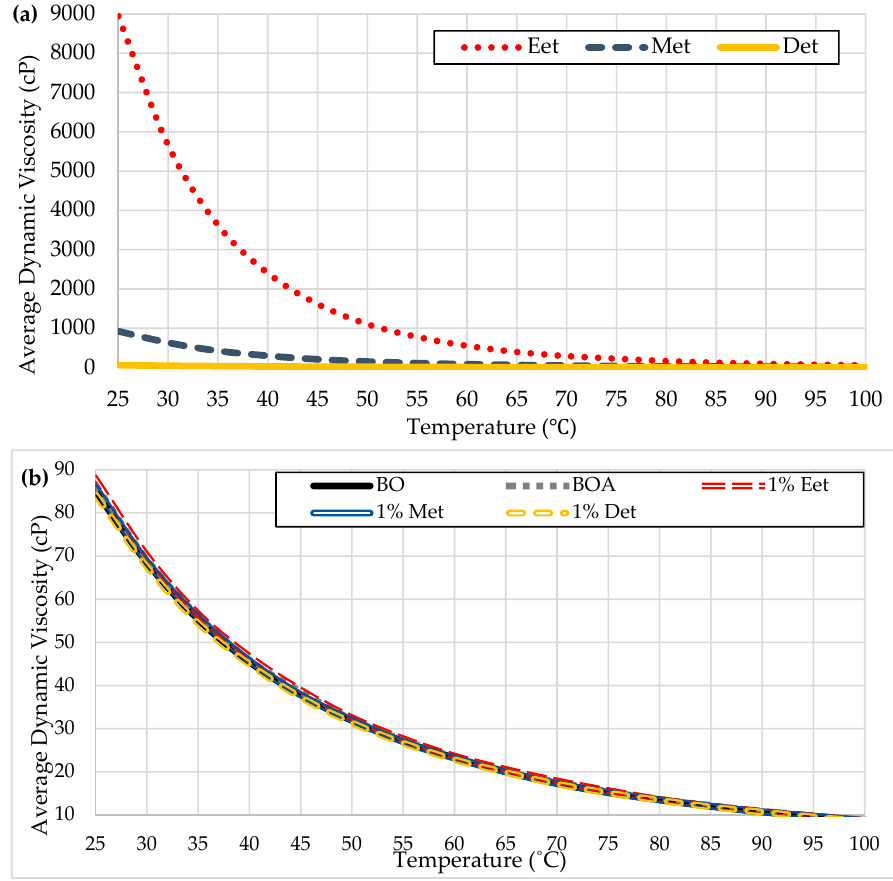
Figure 2. Average dynamic viscosity as a function of temperature for ( a ) the neat PILs and ( b ) biodegradable base (BO), BIO TELEX 46 (BOA), and 1 wt.% PIL Table 4. The viscosity of BO, BOA, neat PILs, and PIL blends. Lubricant